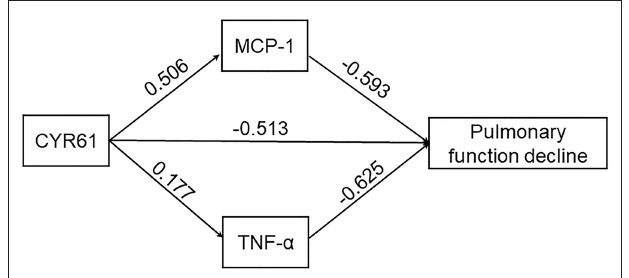
FIGURE 5 | Postulated mediational path model.